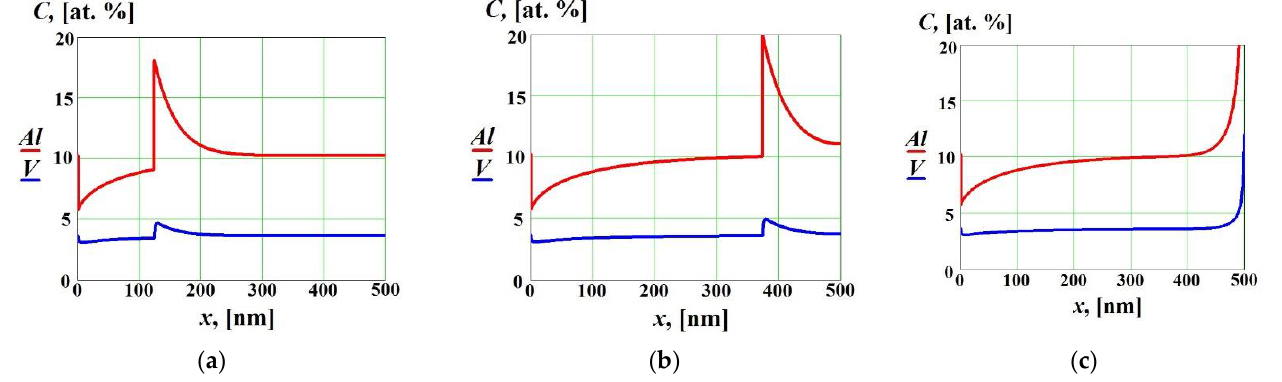
Figure 5. Solute concentrations in the liquid and solid phases as functions of the coordinate x at V < V D and V > V D with strong positive cross diffusion effects ( D 12 = 0, D 21 = 1.5 · 10 − 8 m 2 /s) at